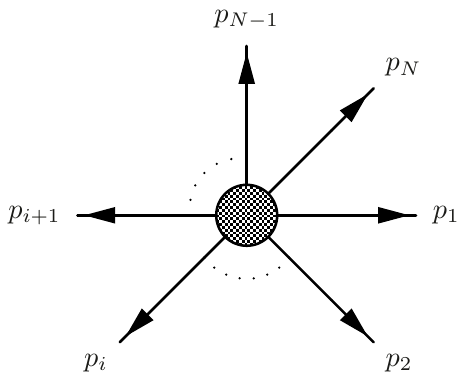
Figure 1 . Non-radiative N -jet